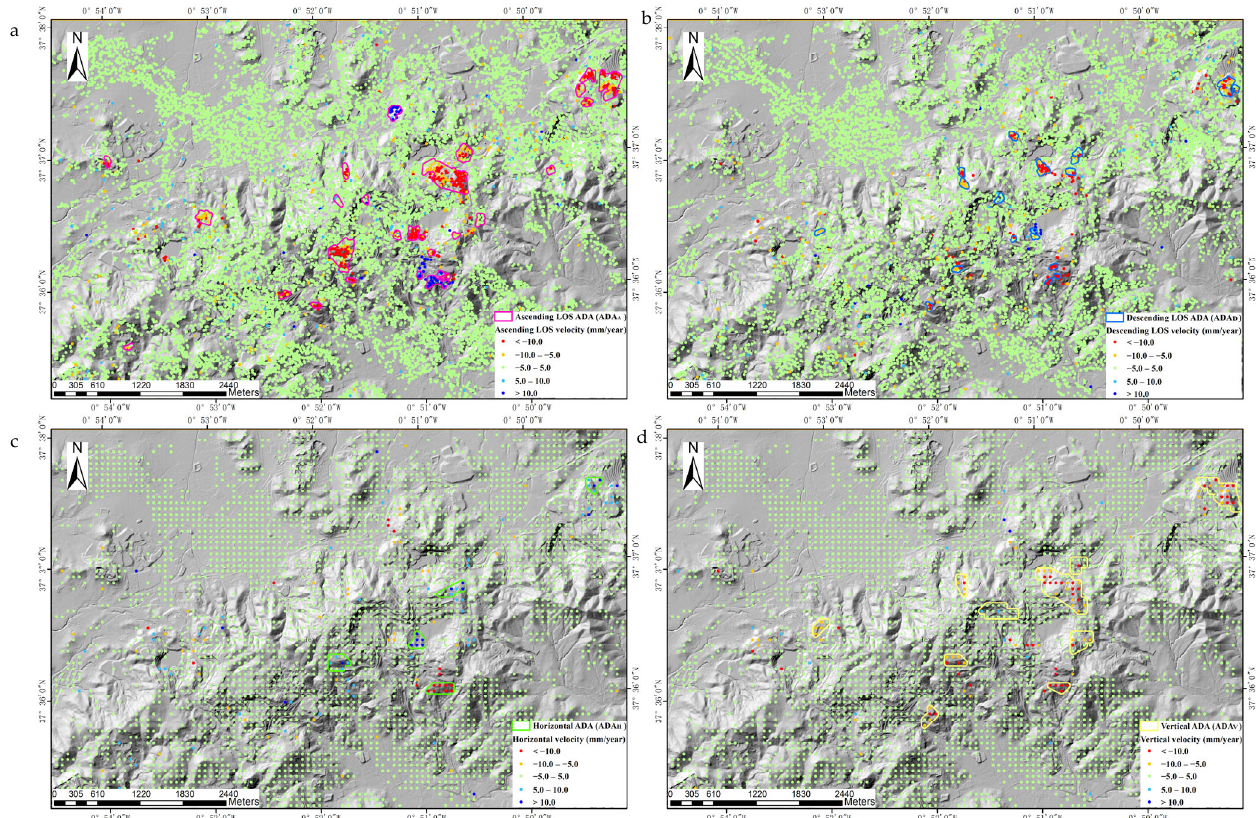
Figure 3. InSAR ascending LOS velocity map ( a ), descending LOS velocity map ( b ), horizontal (east ‐ west) velocity map ( c ) and vertical velocity map ( d ) for the period from October 2016 to November 2021. The pink solid polygons, blue solid polygons, green solid polygons and yellow solid polygons indicate the boundaries of the ADA A , ADA D , ADA H and ADA V , respectively.